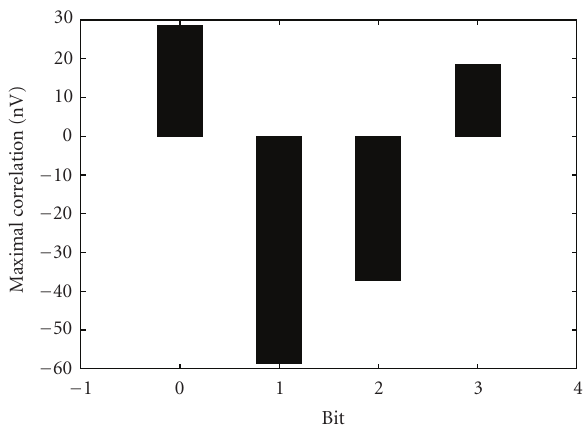
Figure 12: Histogram of SBox1 output bits power